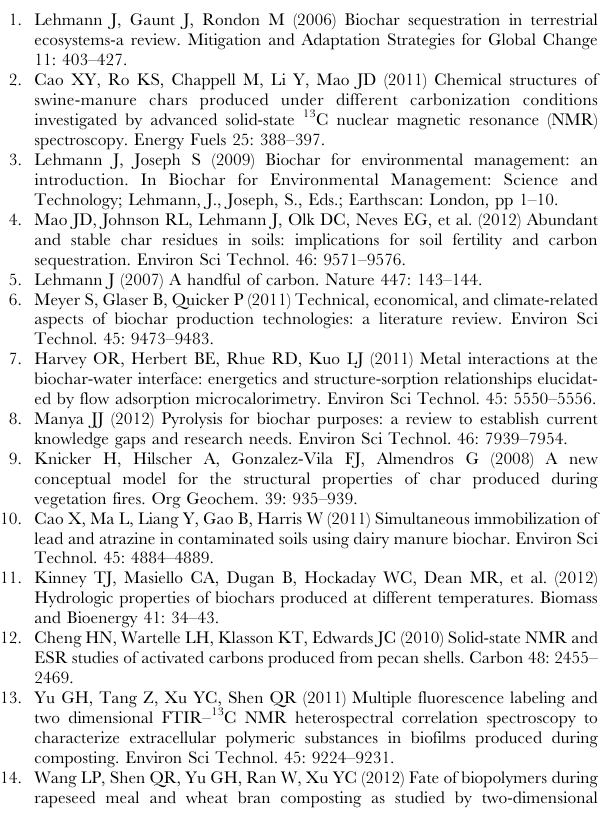
Figure S1 Synchronous 2D 13 C NMR maps of rice straw and sawdust derived biochars over charring tempera- tures (100 , 600 6 C). Red represents positive correlation, and blue represents negative correlation; a higher color intensity indicates a stronger positive or negative correlation.